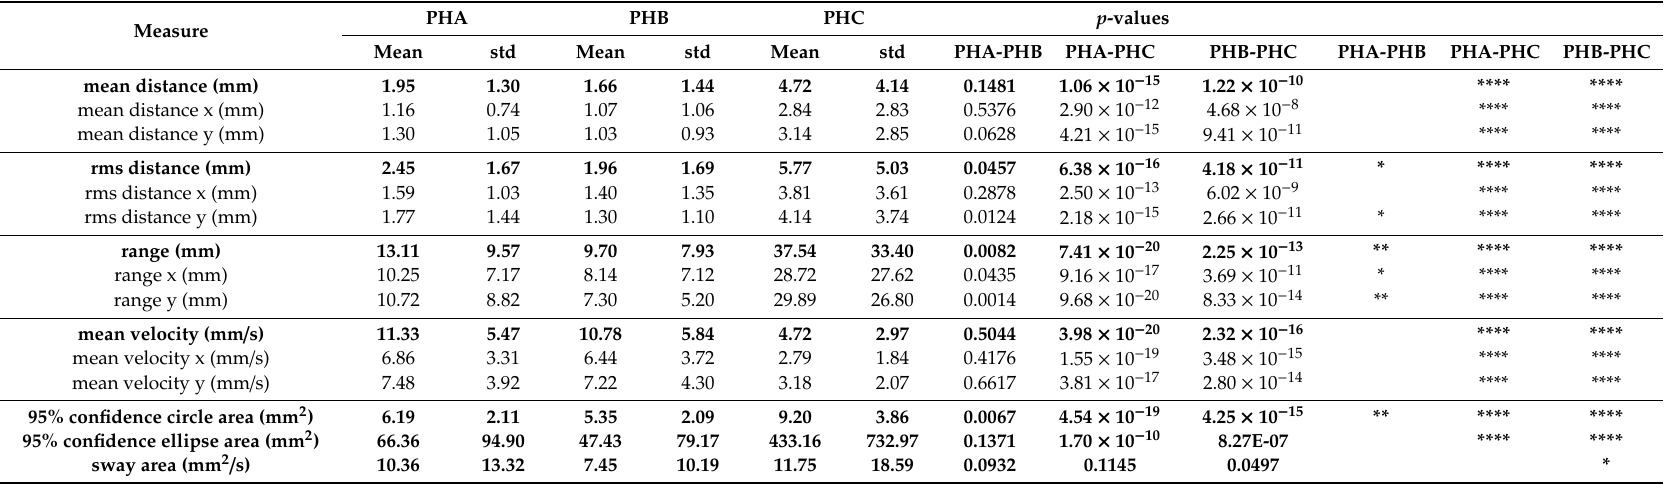
Table 2. UCOP-based descriptive parameters computed for all the volunteers: for each parameter the mean and std values calculated over all participants have been reported for each of the three phases of the test. For the same parameters, the p-value obtained from the multiple pairwise t-tests between phases have been calculated and di ff erent level of significance have been assessed as reported in the following: * p < 0.05, ** p < 0.01, **** p <